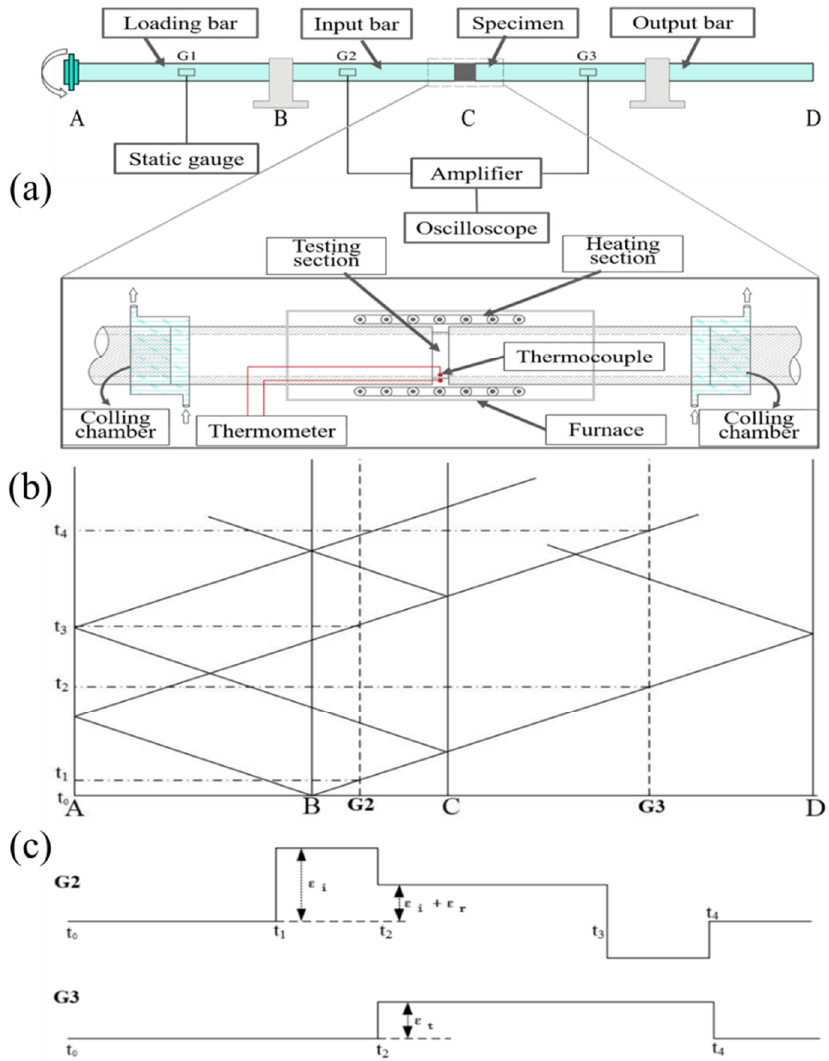
Figure 1. Hopkinson torsion bar experimental device schematic diagram ( a ) and curves of torsional wave propagation and ideal waveforms with constant specimen stiffness: ( b ) wave propagation characteristic line, ( c ) ideal waveform.